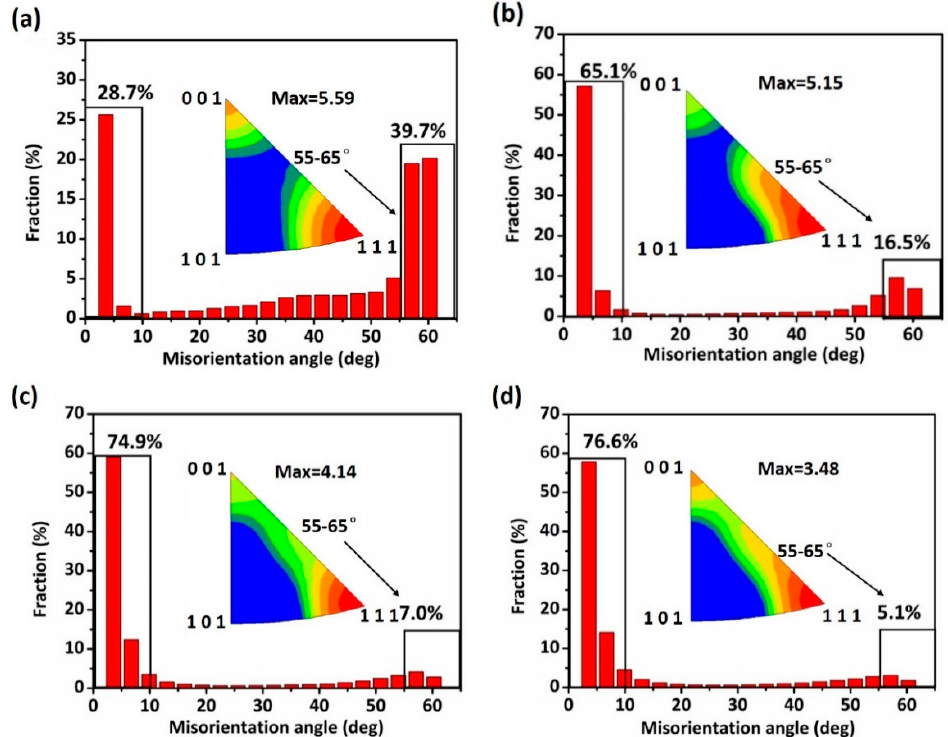
Figure 10. Misorientation distribution and inverse polar figures of Cu strips under different cold rolling reductions: ( a ) 0% reduction, ( b ) 22.7% reduction, ( c ) 58.6% reduction, and ( d ) 77.3% reduction.